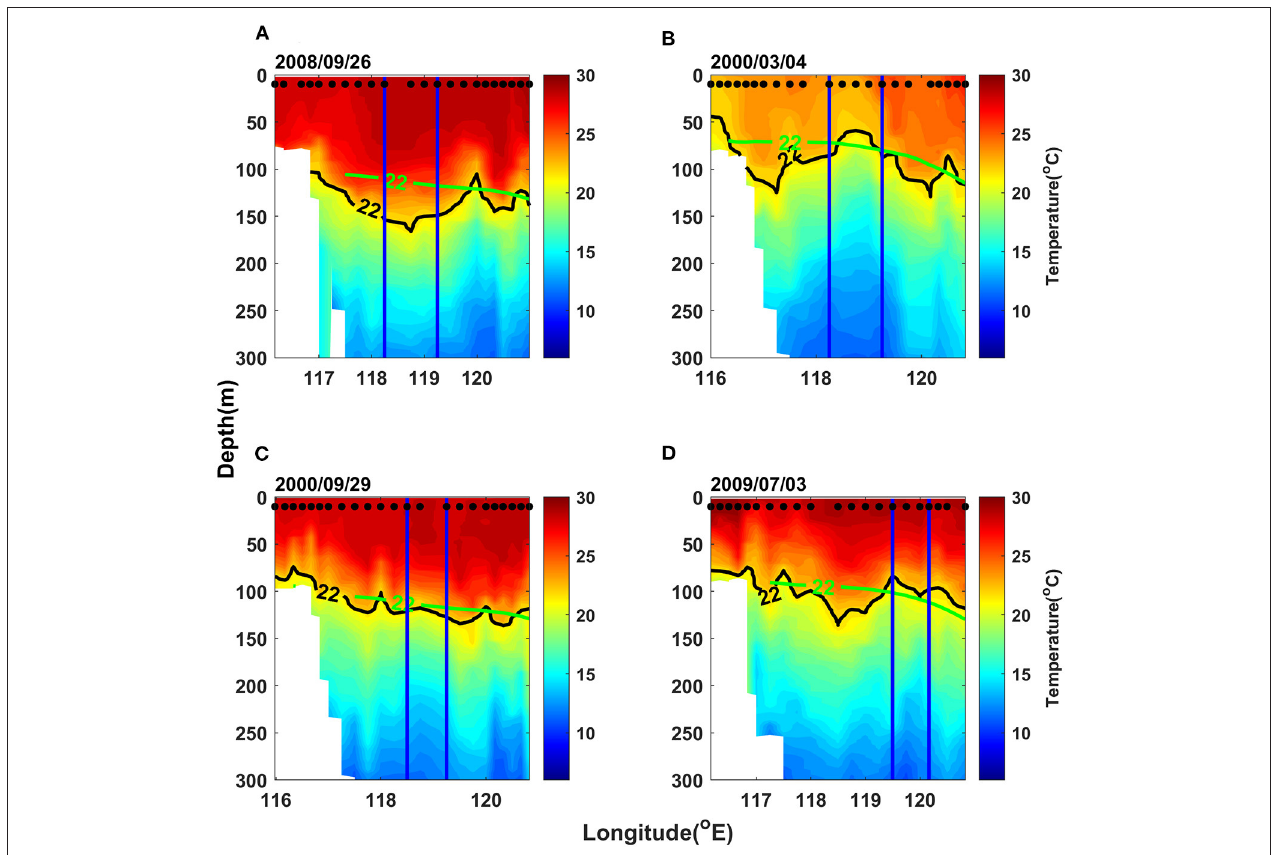
FIGURE 2 | The temperature profiles along the PX44 section on (A) September 26, 2008 (AE1), (B) March 4, 2000 (CE8), (C) September 29, 2000 (AE4), and (D) July 3, 2009 (CE10). The two blue vertical lines in each sub-figure show the region within an eddy confirmed with satellite altimeters. The green curves show the climatological temperature contours at 22 ◦ C. The dots near the surface show the locations of expendable bathythermographs (XBTs). The left (right) panel is for the cases of anticyclonic (cyclonic) eddies, while the upper (lower) panel is for the cases with (without) significant eddy pumping.